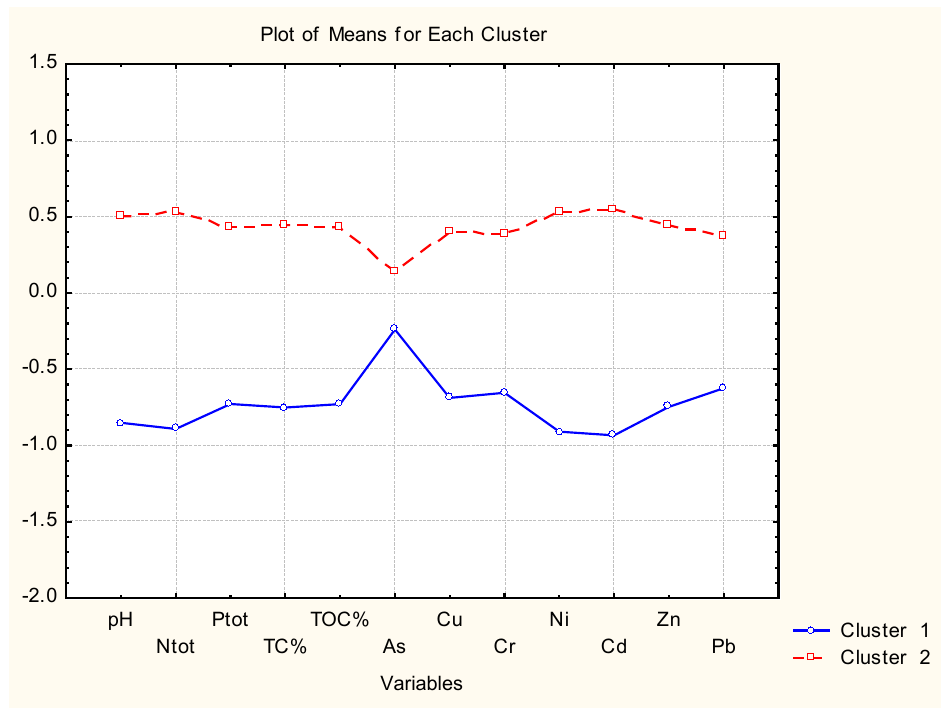
Figure 4: Plot of mean values for each chemical parameter for each of the clusters found.